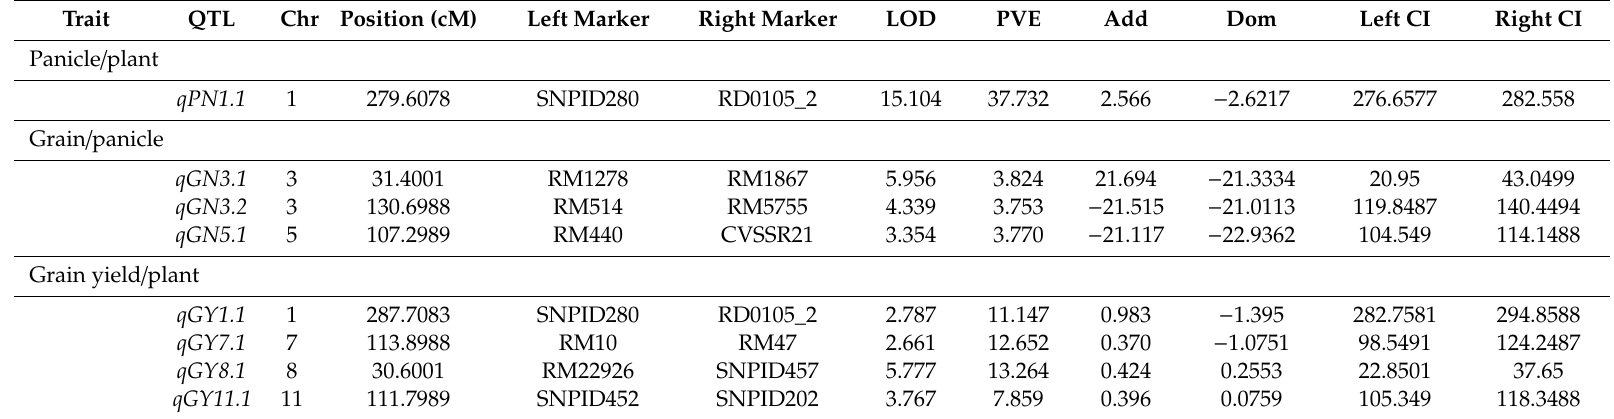
Table 1. Quantitative trait loci (QTL) identified for yield traits in F 2:3 progenies derived from Cocodrie × N22 under greenhouse drought. Trait QTL Chr Position (cM) Left Marker Right Marker LOD PVE Add Dom Left CI Right